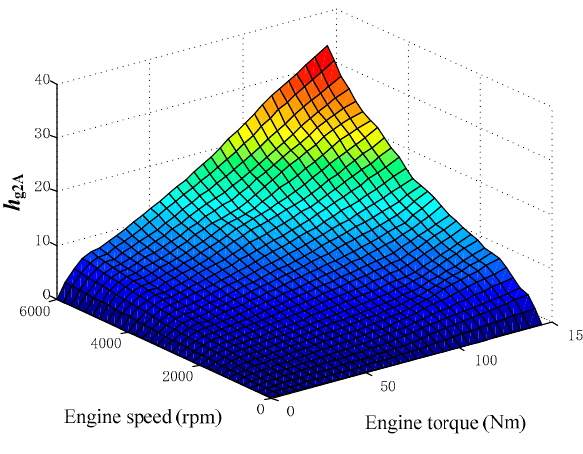
Figure 12. The map of h g 2 A .